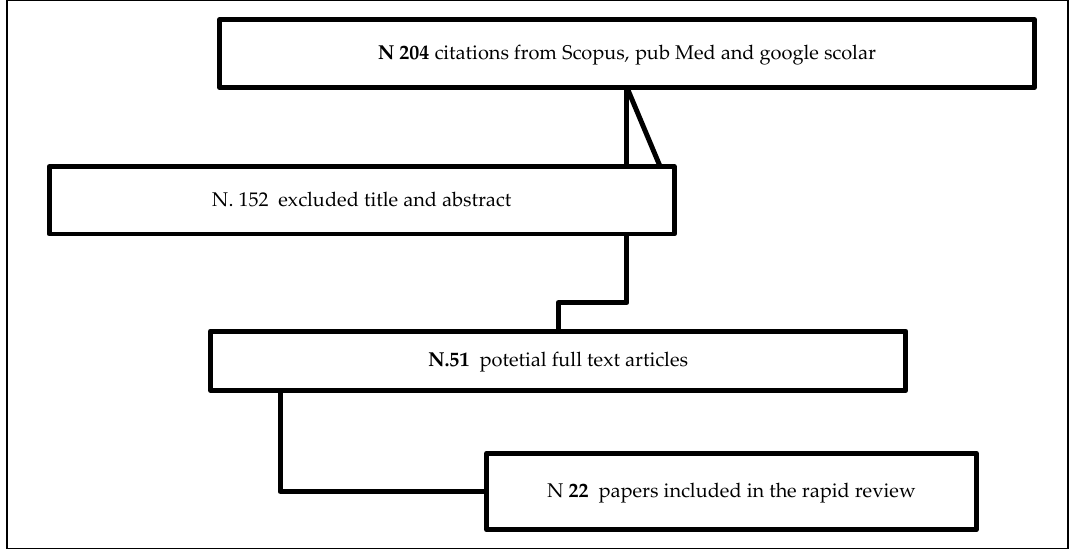
Figure 1. Flowchart of rapid review.